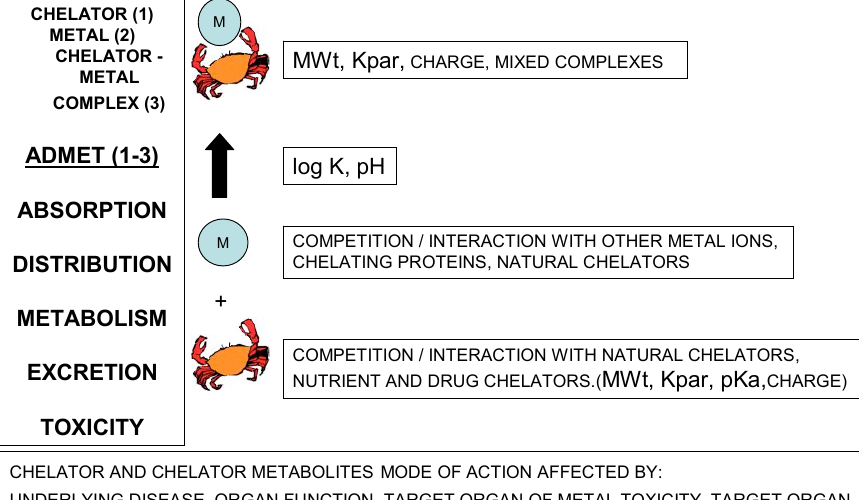
Figure 1. Factors a ff ecting the e ffi cacy and toxicity of chelators and chelator metal complexes. Many factors can influence chelating activity in biological systems including the chelator physicochemical, metabolic, pharmacolocical and toxicological properties. Some of the properties which influence the biological activity of chelators and chelator metal complexes include the equilibrium constant (log K) of metal complex formation, the molecular weight (MWt), lipid / water partition coe ffi cient (Kpar), the charge of the chelator which depends on the pKa of ligands and the pH.